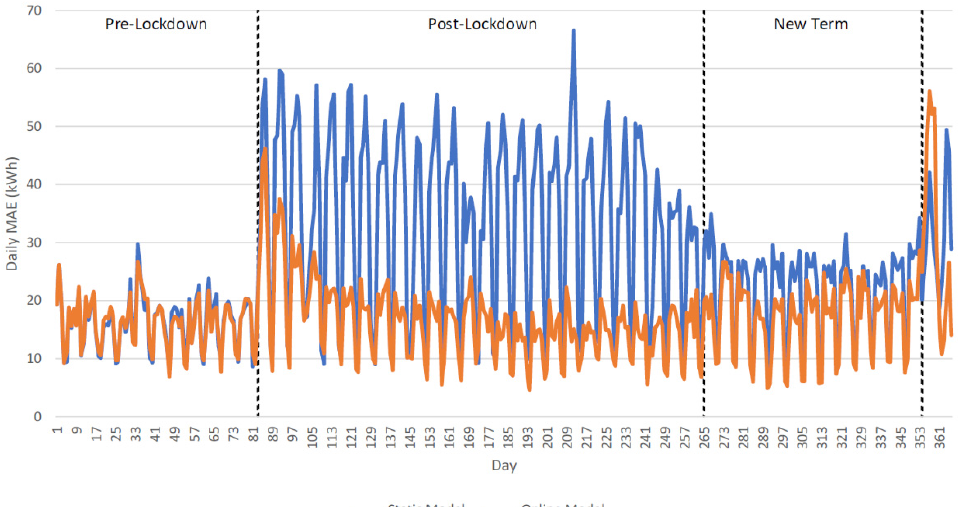
Figure 9. Average results across 10 models tested on the 2020 data with online machine learning. Equivalent results for the static model without online machine learning are also shown for compar- ison.